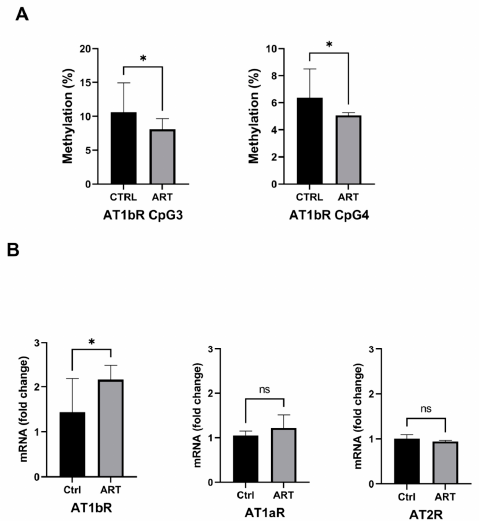
Figure 3. ( A ) At1bR gene promoter DNA methylation level determined by bisulfite pyrosequencing. ( B ) ATRs mRNA quantification in aorta by RT-qPCR in ( n ≥ 10/group). Values are mean ± SE. * p < 0.05, ART vs. Ctrl. ns = not significant.